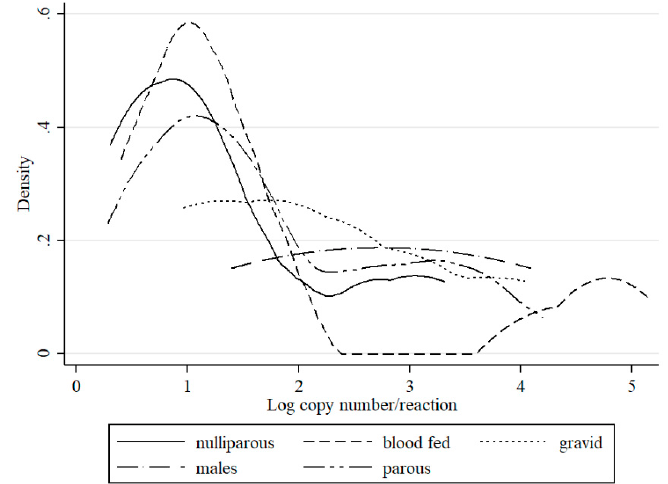
Figure 3. Distribution of estimated RNA copy numbers per sample (logarithm) values of QRT-PCR for SBV detection by kernel density plot with respect to gender or female parity status .